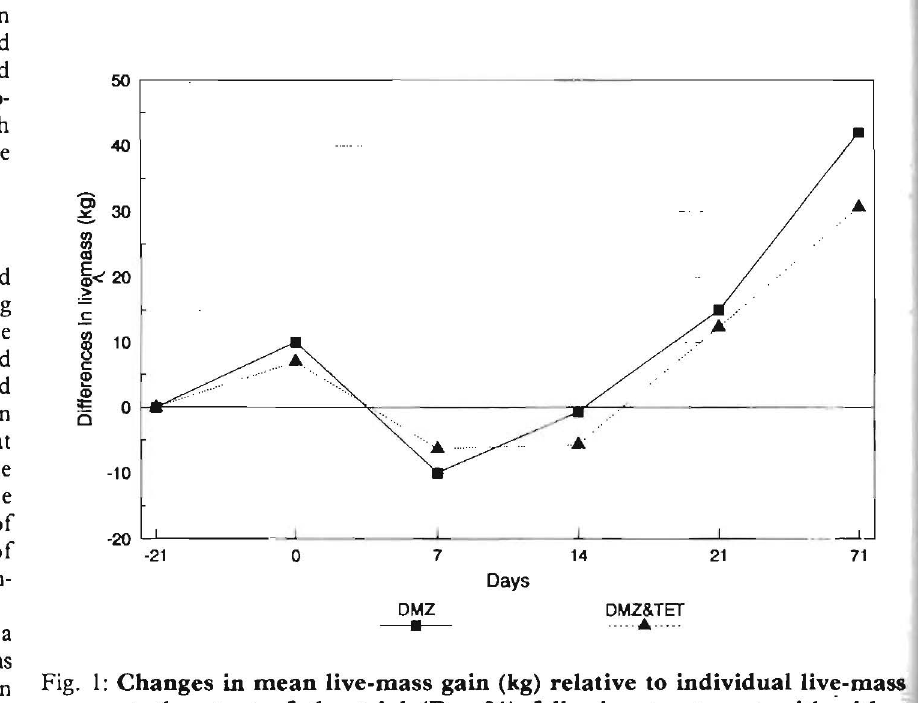
Fig. I: Changes in mean live-mass gain (kg) relative to individual live-mass